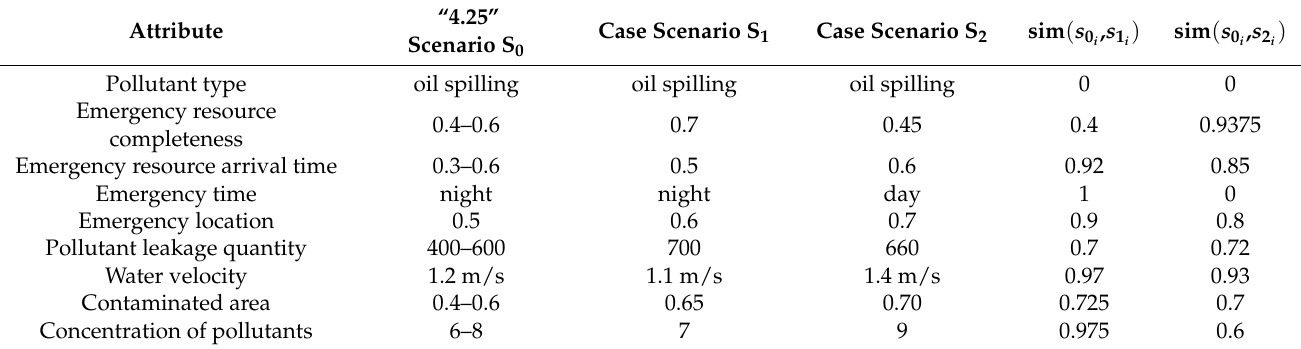
algorithm between “4.25 event” and case scenarios S 1 and S 2 . The calculation example of